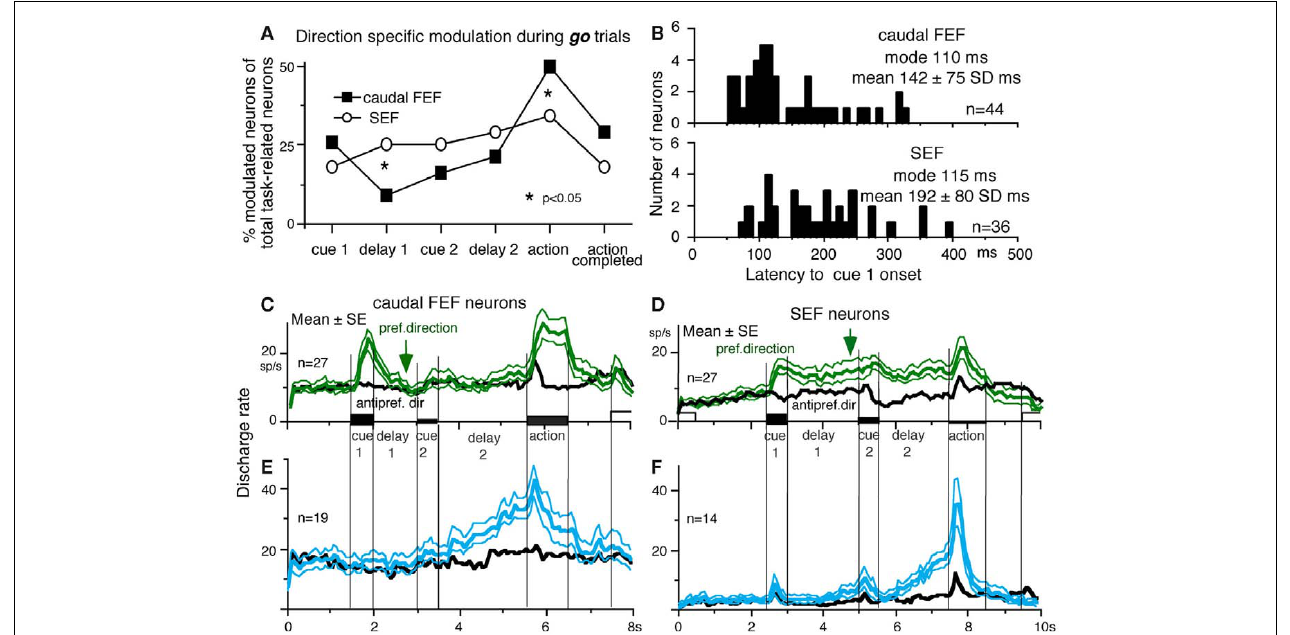
cue 1 during go trials. (D) Mean ± SE discharge of 27 SEF neurons that exhibited directional visual motion response to cue 1 during go trials. In (C,D) , green and black traces are discharge modulation in the preferred direction and anti-preferred direction, respectively. (E,F) Mean ± SE discharge of movement–preparation neurons in the caudal FEF (E) and SEF (F) during go trials. Blue and black traces are discharge modulation in the preferred direction and anti-preferred direction, respectively. (D,F) Reproduced from Shichinohe et al. (2009) with permission. Others reproduced from Fukushima et al. (2011a) with